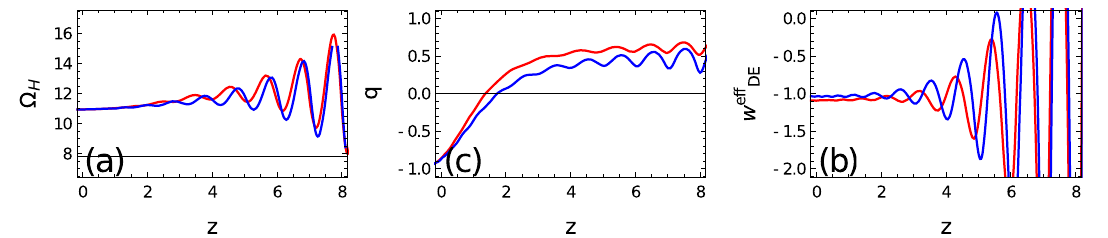
Fig. 10 Variation of dark energy variables, Ω H (left), deceleration parameter q (middle) and the effective EoS parameter w ef f exponential interaction (blue) and with linear interaction (red) considering η = 0 . 09 and α = 0 . 1